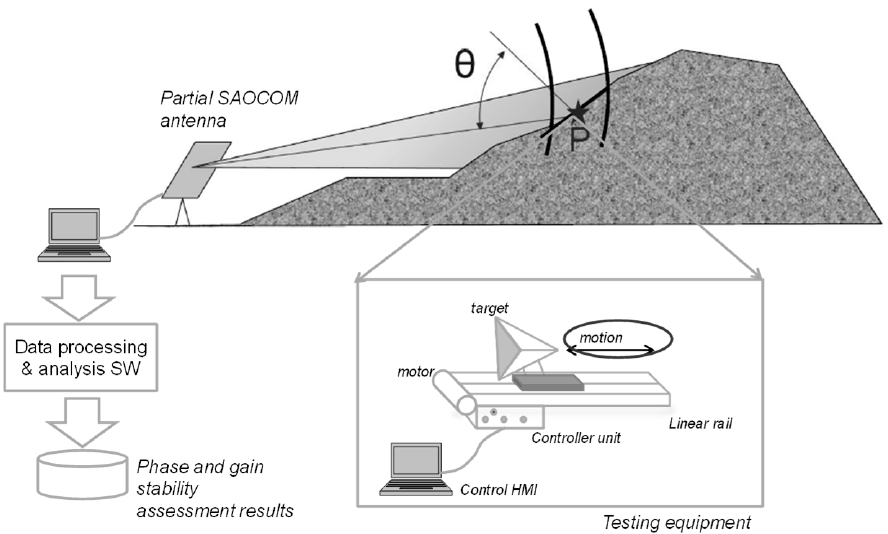
Figure 1. SAOCOM outdoor test (ODT) concept overall view. In the figure, P represents the moving target to be acquired and ϑ the inclination of the Radar Line of Sight with respect to the local normal to the terrain.